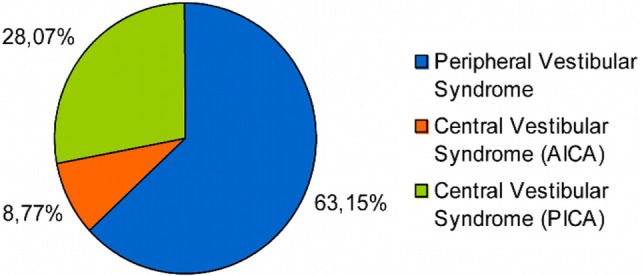
Distribution of lesions in patients with AVS.